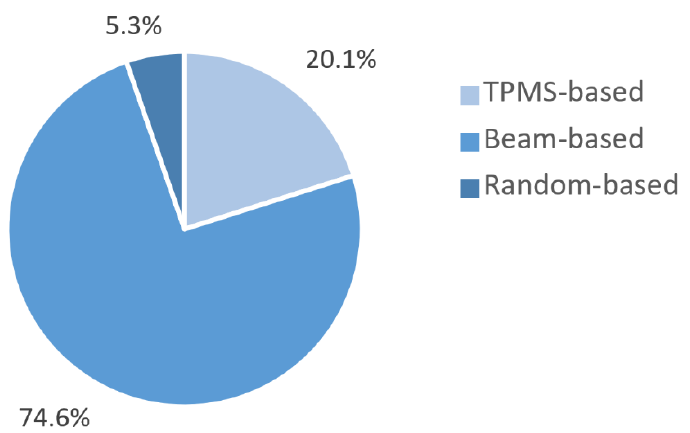
Figure 6. Distribution of experimental studies on beam-based, triply periodic minimal surfaces (TPMS),